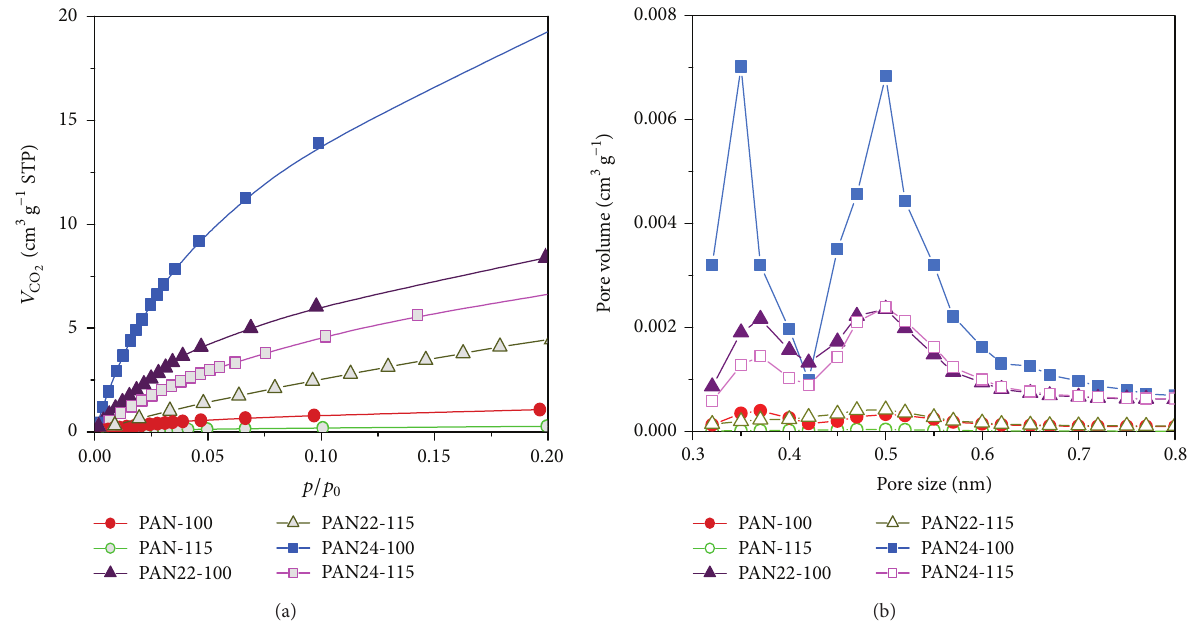
Figure 4: CO 2 adsorption isotherms of 1000 ∘ C carbons from pristine and oxidized PAN.